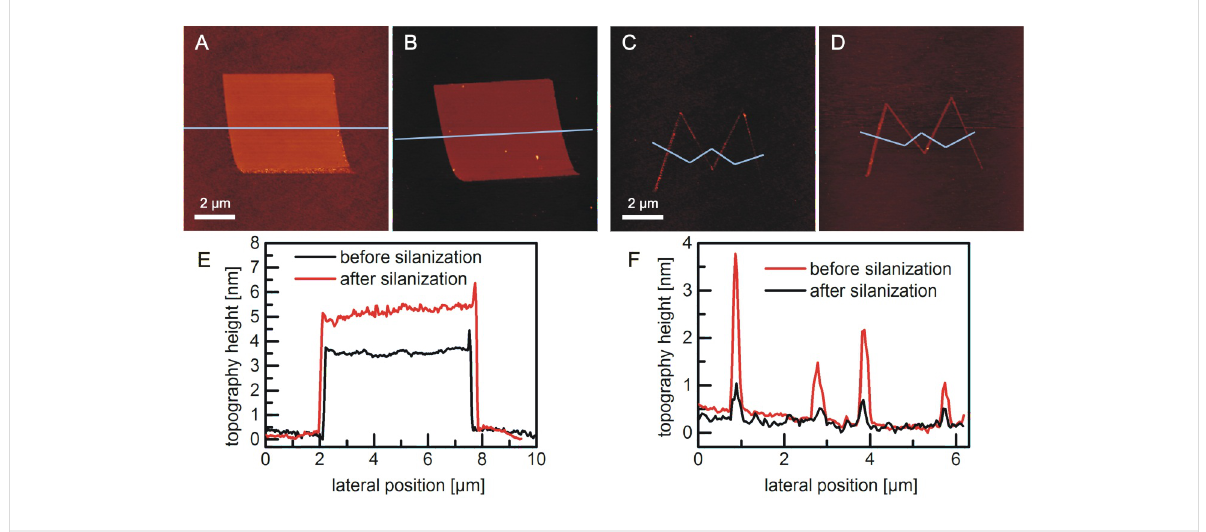
Figure 4: AFM height images of LAO oxide structures before (A, C) and after (B, D) 16 h in a 10 mM 11-bromoundecyltrichlorosilane solution in dry toluene under dry conditions. (E, F) topography profile along the lines in (A–D) averaged over a width of 10 pixels.